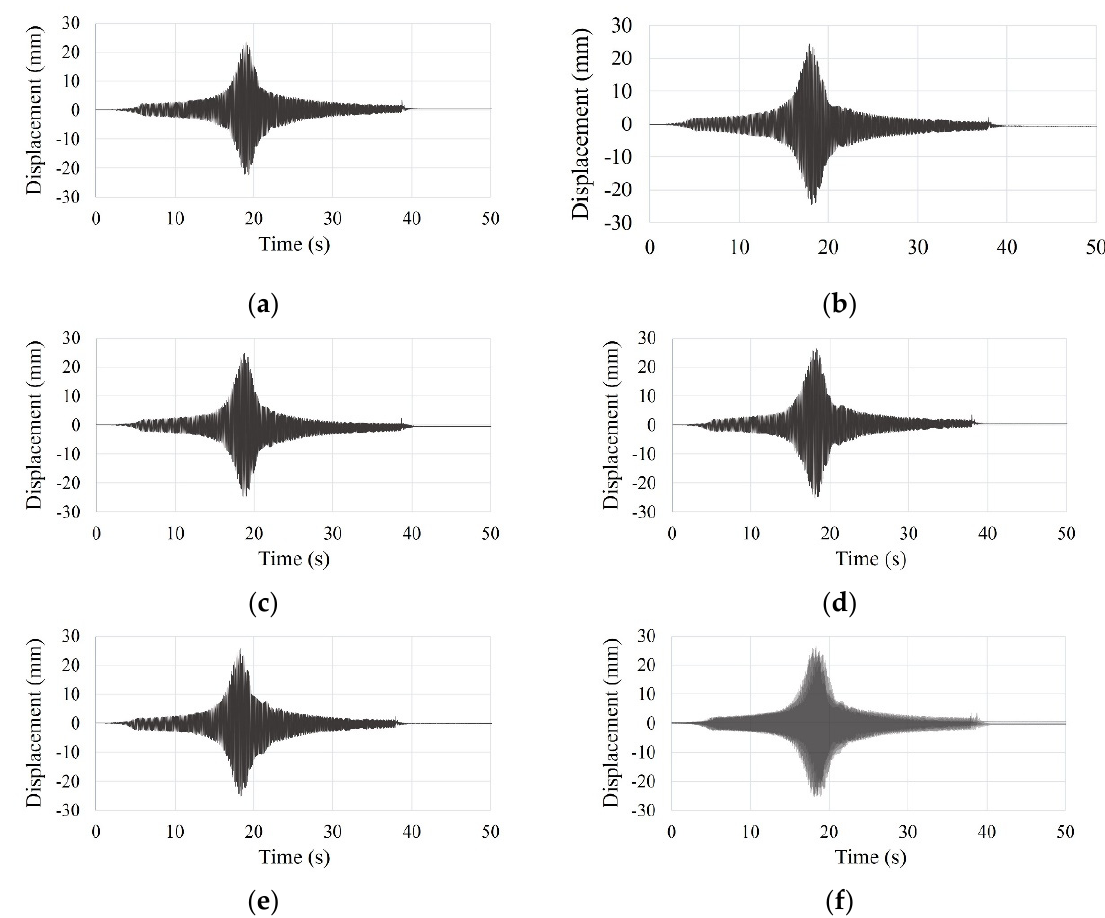
Figure 10. Time history curve of the SDOF model by sinusoidal forced vibration test: ( a ) first test;